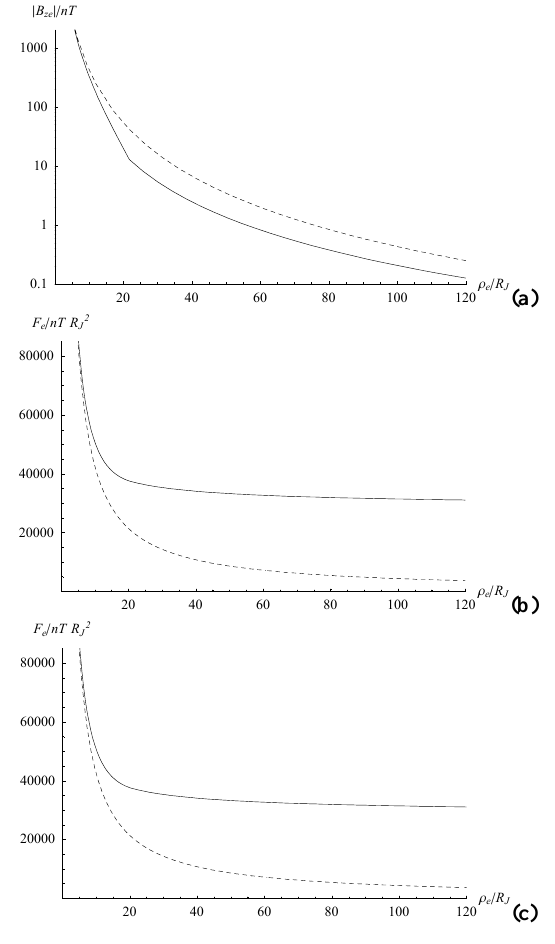
Fig. 4. Plots showing parameters of the current sheet field model employed in Sect. 4 (solid lines), compared with values for the plan- etary dipole field alone (dashed lines). Plot (a) is a log-linear plot of the modulus of the north-south equatorial magnetic field | B ze | threading the equatorial plane, shown versus jovicentric equatorial radial distance ρ e . This field component is actually negative (i.e. points south) in both cases. The kink in the curve at ∼ 21.78R J in the current sheet model marks the point where we switch from the ‘CAN’ model to the ‘KK’ model, as discussed in the text. Plot (b) similarly shows the equatorial flux function F e of the model fields versus jovicentric equatorial radial distance ρ e . Plot (c) shows the mapping of the field lines between the equatorial plane and the iono- sphere, determined from Eq. (1). The ionospheric dipole co-latitude of the field line is plotted versus jovicentric equatorial radial dis- tance ρ e .